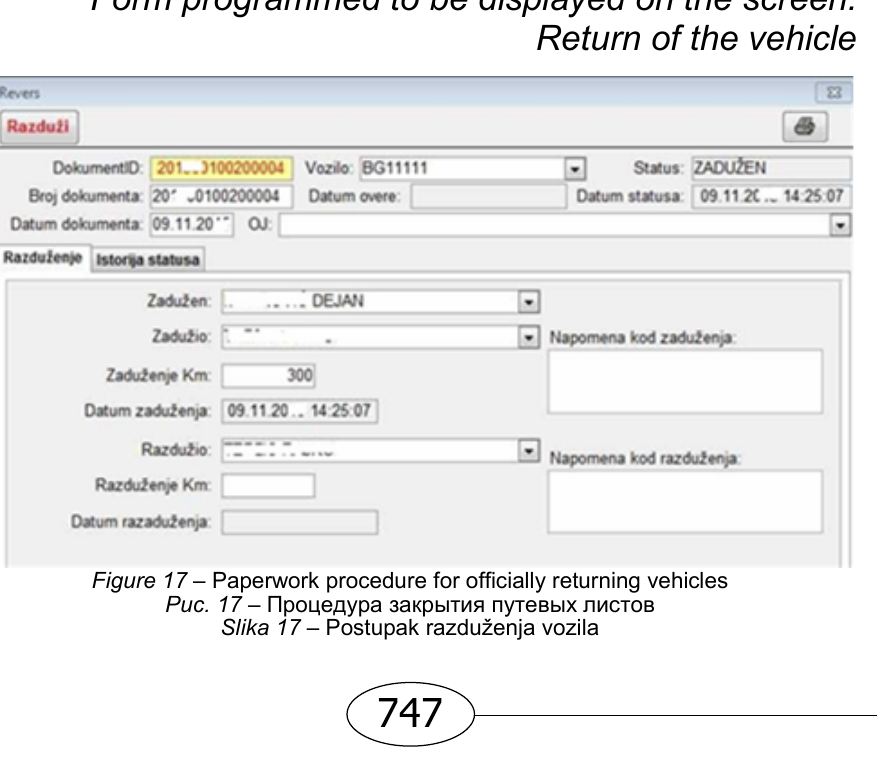
Figure 16 – Procedure of allocating vehicles Рис . 16 – Процедура оформления транспортного средства